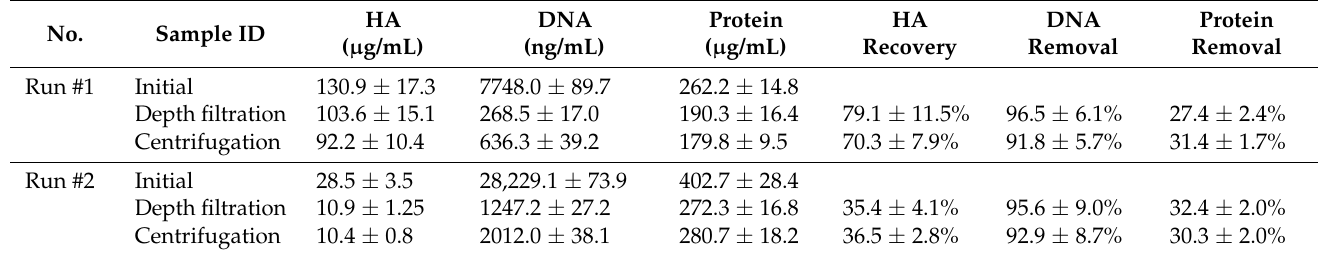
Table 2. Comparison of clarification methods between centrifugation and depth